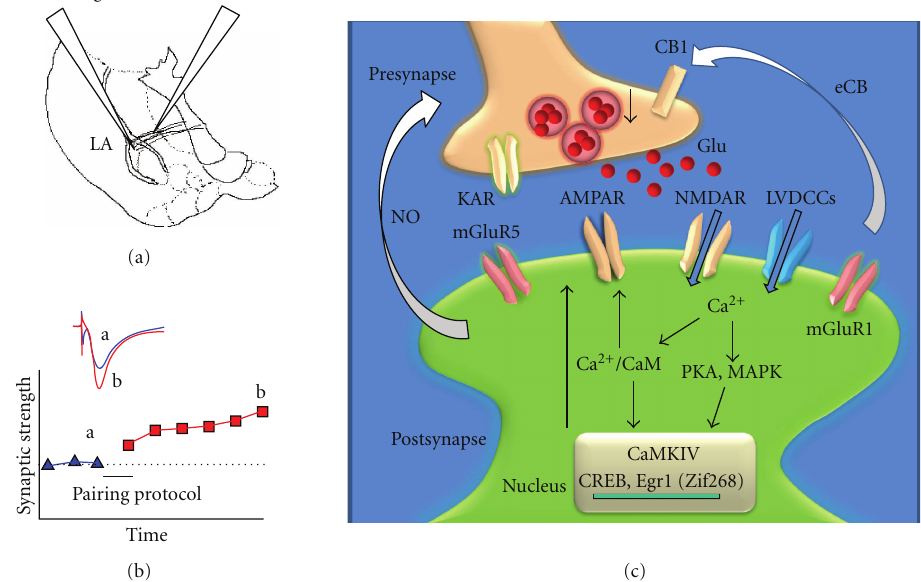
Figure 2: A cellular model for LTP in the lateral amygdale. (a) Diagram of an amygdala slice showing the placement of whole-cell patch- clamp recording and stimulation electrode. (b) LTP is induced by 80 pulses at 2Hz with postsynaptic holding at +30mV. (c) Activations of postsynaptic glutamate NMDA receptors and L-VDCCs lead to an increase in postsynaptic Ca 2+ in dendritic spines. Ca 2+ binds to CaM and leads to activation of Ca 2+ /CaM-dependent protein kinases (PKA, CaMKII, and CaMKIV). Subsequently, AMPA receptor will undergo plastic upregulation. Activation of CaMKIV, a kinase predominantly expressed in the nuclei, will trigger CREB signaling pathways. MAPK could translocate from the cytosol to the nucleus and then regulate CREB activity. mGluR5 and presynaptic KA receptors are involved in induction of LTP. Induction of thalamic LTP suppresses the presynaptic LTP by activation of presynaptic CB1 receptors by eCB released in response to activation of